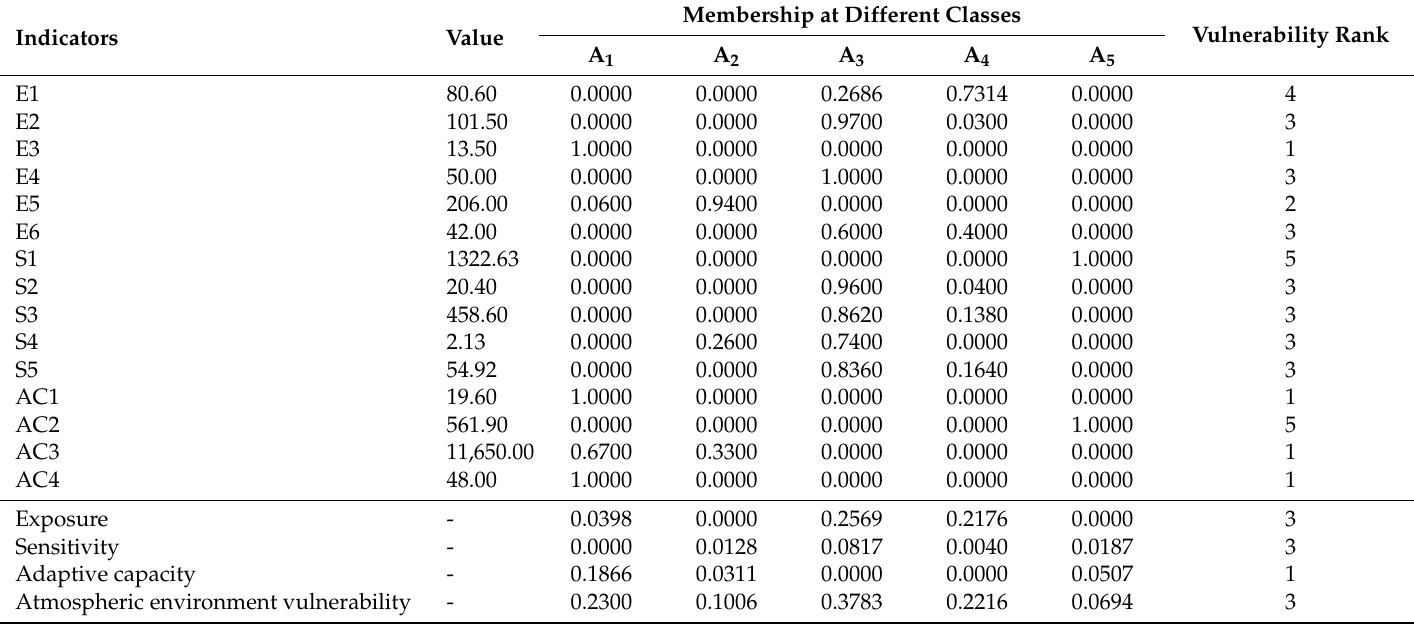
Table 4. Fuzzy membership calculation results for Beijing’s atmospheric environment vulnerability in